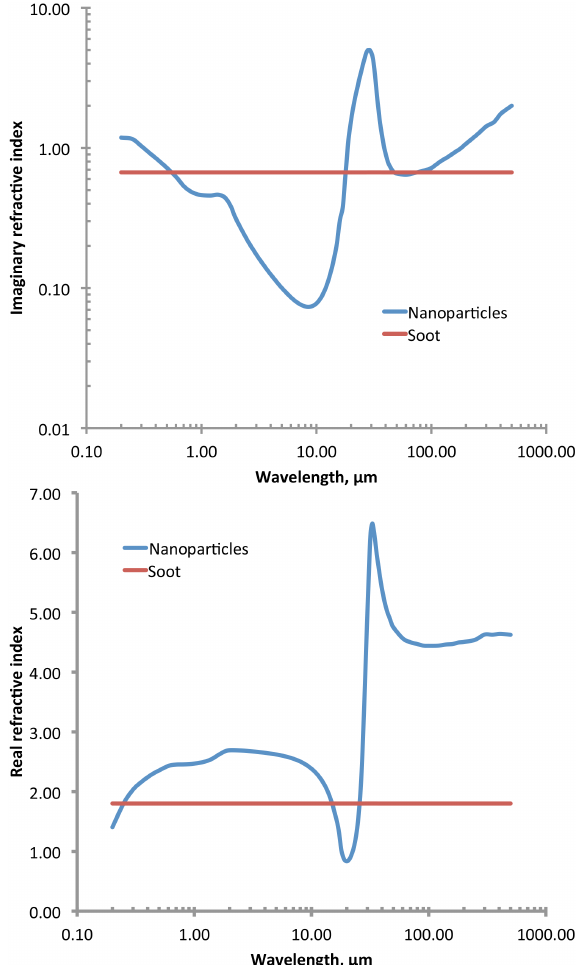
Figure 3. The real and imaginary parts of the refractive index sug- gested for nanoparticles, and for